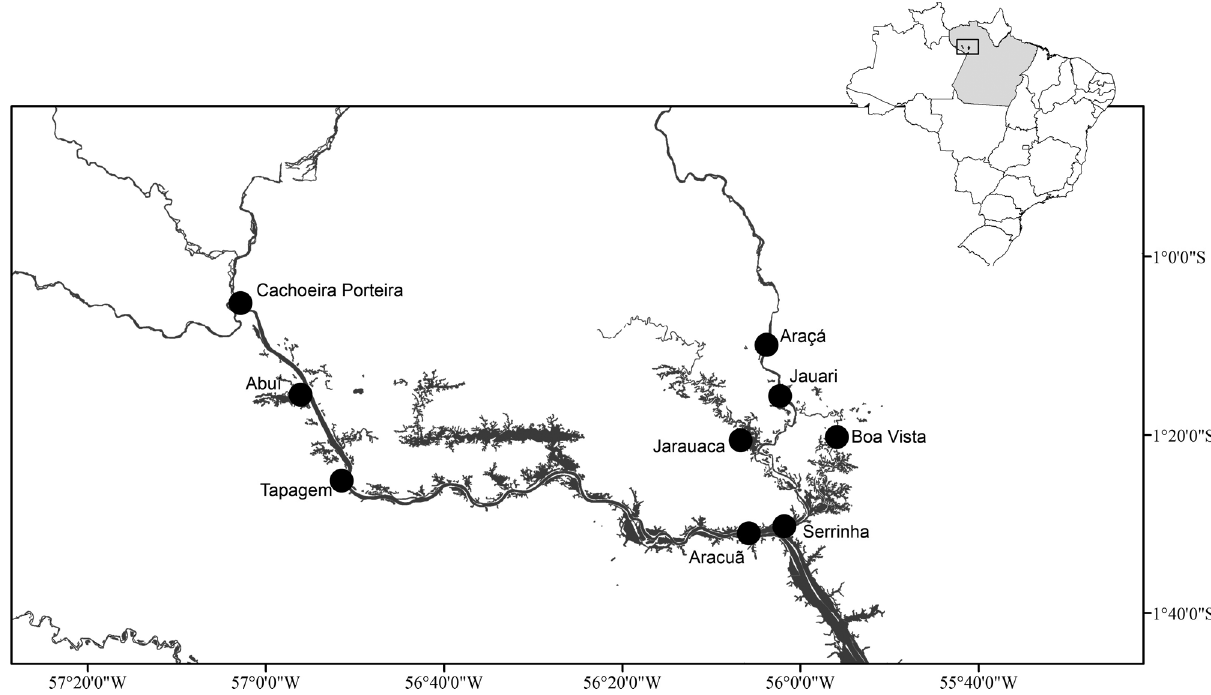
Figure 1 - Geographical locations of Afro-descendant communities in the municipality of Oriximiná, northeast of the state of